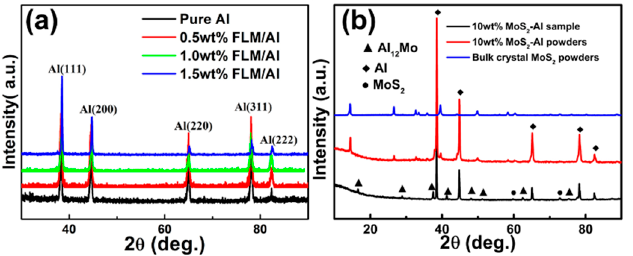
Figure 7. XRD analysis of ( a ) FLM/Al composites sintered at 630 °C, ( b ) bulk crystal MoS 2 composite powders and bulk sample sintered at 630 °C.